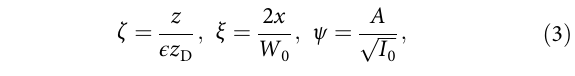
Fig. 1a. The output wave pro fi le depends on its genus content, which varies with t . Following the theoretical approach in ref. 40 , the two separatrix equations divide the evolution diagram in Fig. 1a into three different areas: the fl at box plateau with genus g ¼ 0, the lateral counterpropagating DSWs with genus g ¼ 1, and the RWs after the DSW-collision point (corresponding to the separatrices intersection) with genus g ¼ 2. The two separatrices (dashed ffiffiffiffiffiffiffiffiffiffiffiffiffiffiffiffiffiffiffiffiffiffiffiffiffi lines in Fig. 1a) have equations